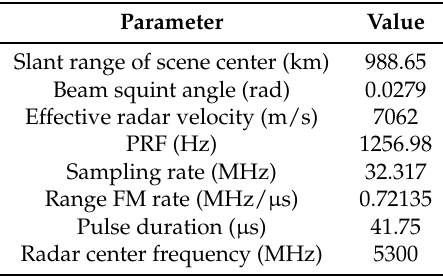
Table 2. RADARSAT-1